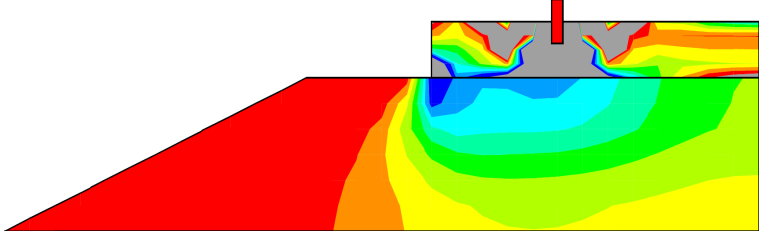
Figure 7. Static vertical stress in the 3D FE model of the railway track. Blue: maximum negative stress in the ballast; red: 0% to 10% of the maximum negative stress; grey: values out of range; h b = 0.6 m. In [3], the superposition of the stress cones in the longitudinal direction is considered.